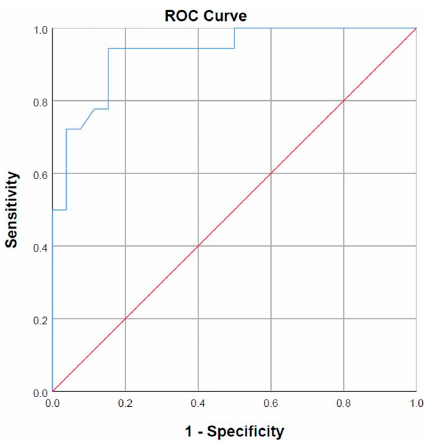
Figure 2. Sensitivity and specificity of FHPapp (COR (Characteristic Operating Receiver) curve).